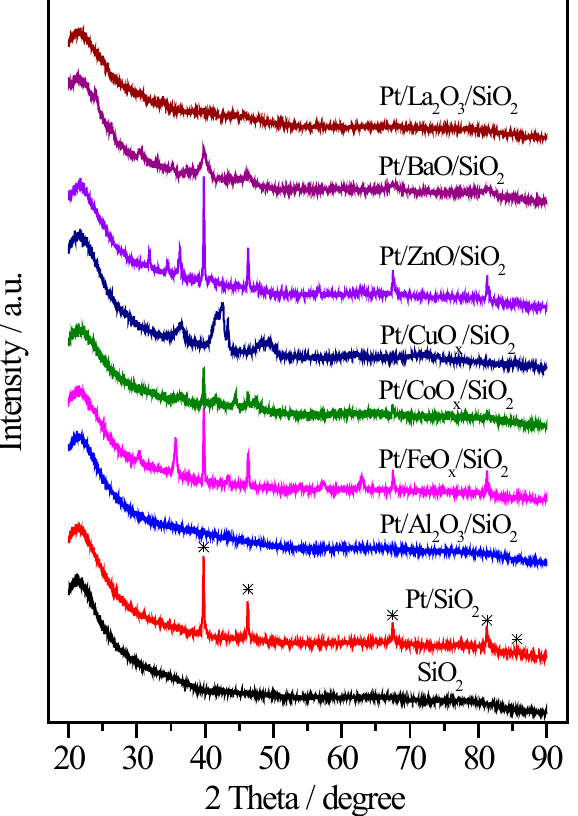
Figure 1. CO conversions on Pt/MO x /SiO 2 catalysts as a function of reaction temperature.